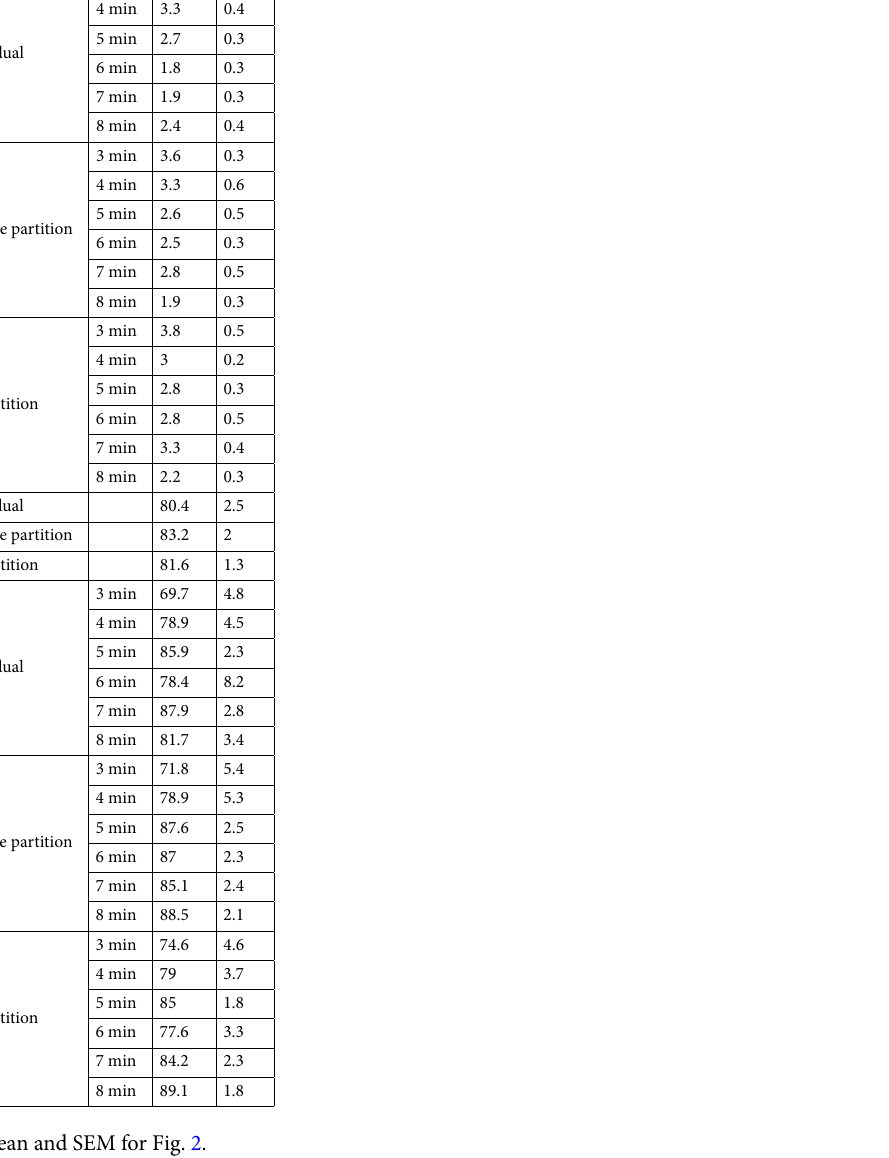
difference between the three groups in the percentage of time spent immobile (Fig. 2d; F 2,33 = 0.478.0, p = 0.624, e ; F 10,165 = 0.659, p = 0.761, Table 1). Behaviour of two mice simultaneously undergoing the Porsolt forced swim test. The total number of immobility episodes was significantly lower in the opaque partition group than in the individual group (Fig. 3b; F 2,33 = 2.518, p = 0.960, Table 2), and tended to be lower in the no-partition group than in the individual group (Fig. 3b). The total immobility time was significantly longer in the no-partition group than in the individual group (Fig. 3d; F 2,33 = 2.878, p = 0.071, Table. 2), and tended to be longer in the opaque group than in the individual group (Fig. 3d). We found no significant differences in the immobile episodes in each 1-min period among the three groups (Fig. 3c; F 10,165 = 1.208, p = 0.289, Table. 2), although it tended to be longer in the no-partition group than in the individual group (Fig. 3e; F 10,165 = 0.726, p = 0.491, Table. 2).